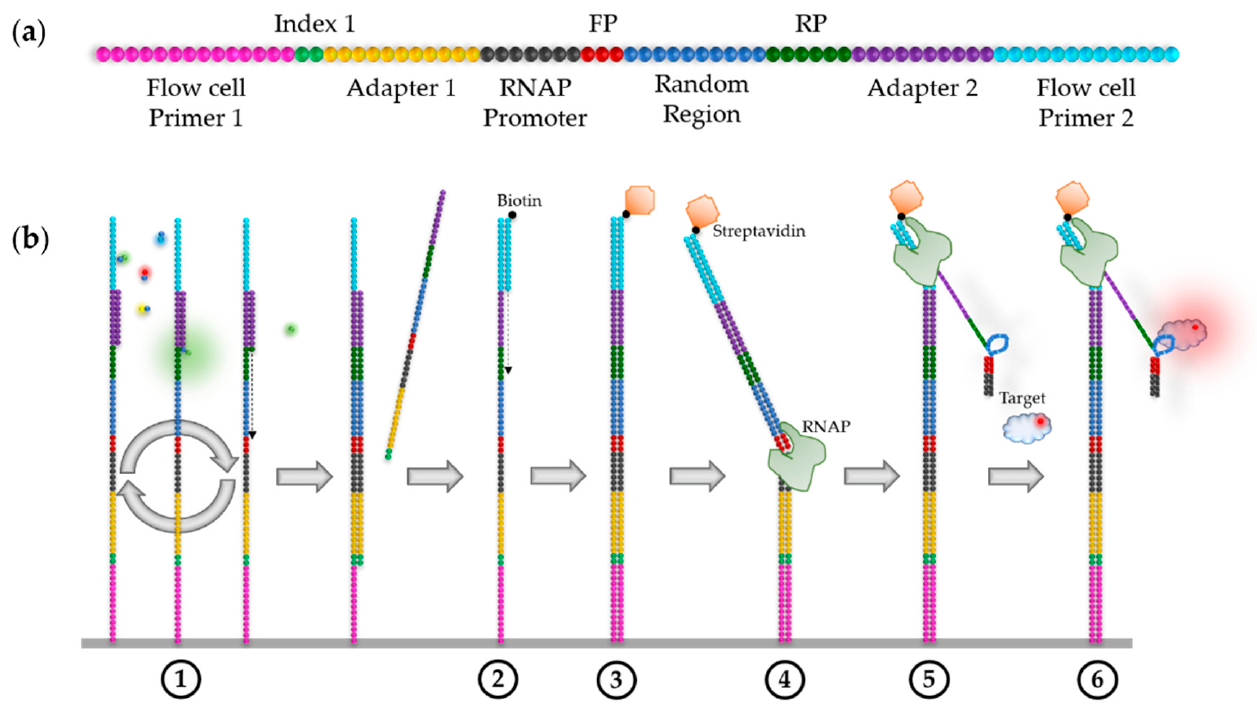
Figure 4. Schematic illustration of the RNA–MaP experiment, according to Buenrostro et al. [31]. ( a ) The initial DNA library designed for single-end sequencing, similar to the one used for DNA aptamer selection (Section 4.1), but with a RNA polymerase (RNAP) promotor at the 5 ′ end of the aptamer sequence. ( b ) The RNA–MaP process.